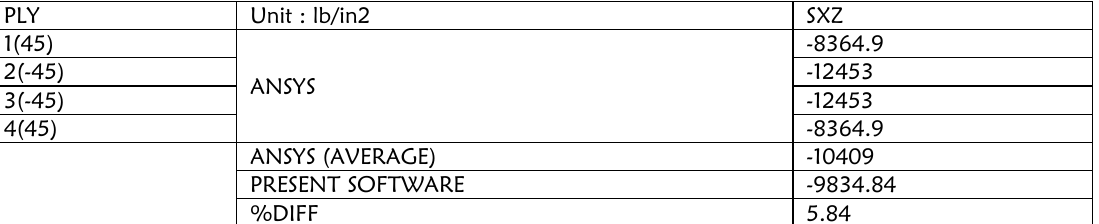
Table 9: Average shear stress on the web of I-beam due to shear